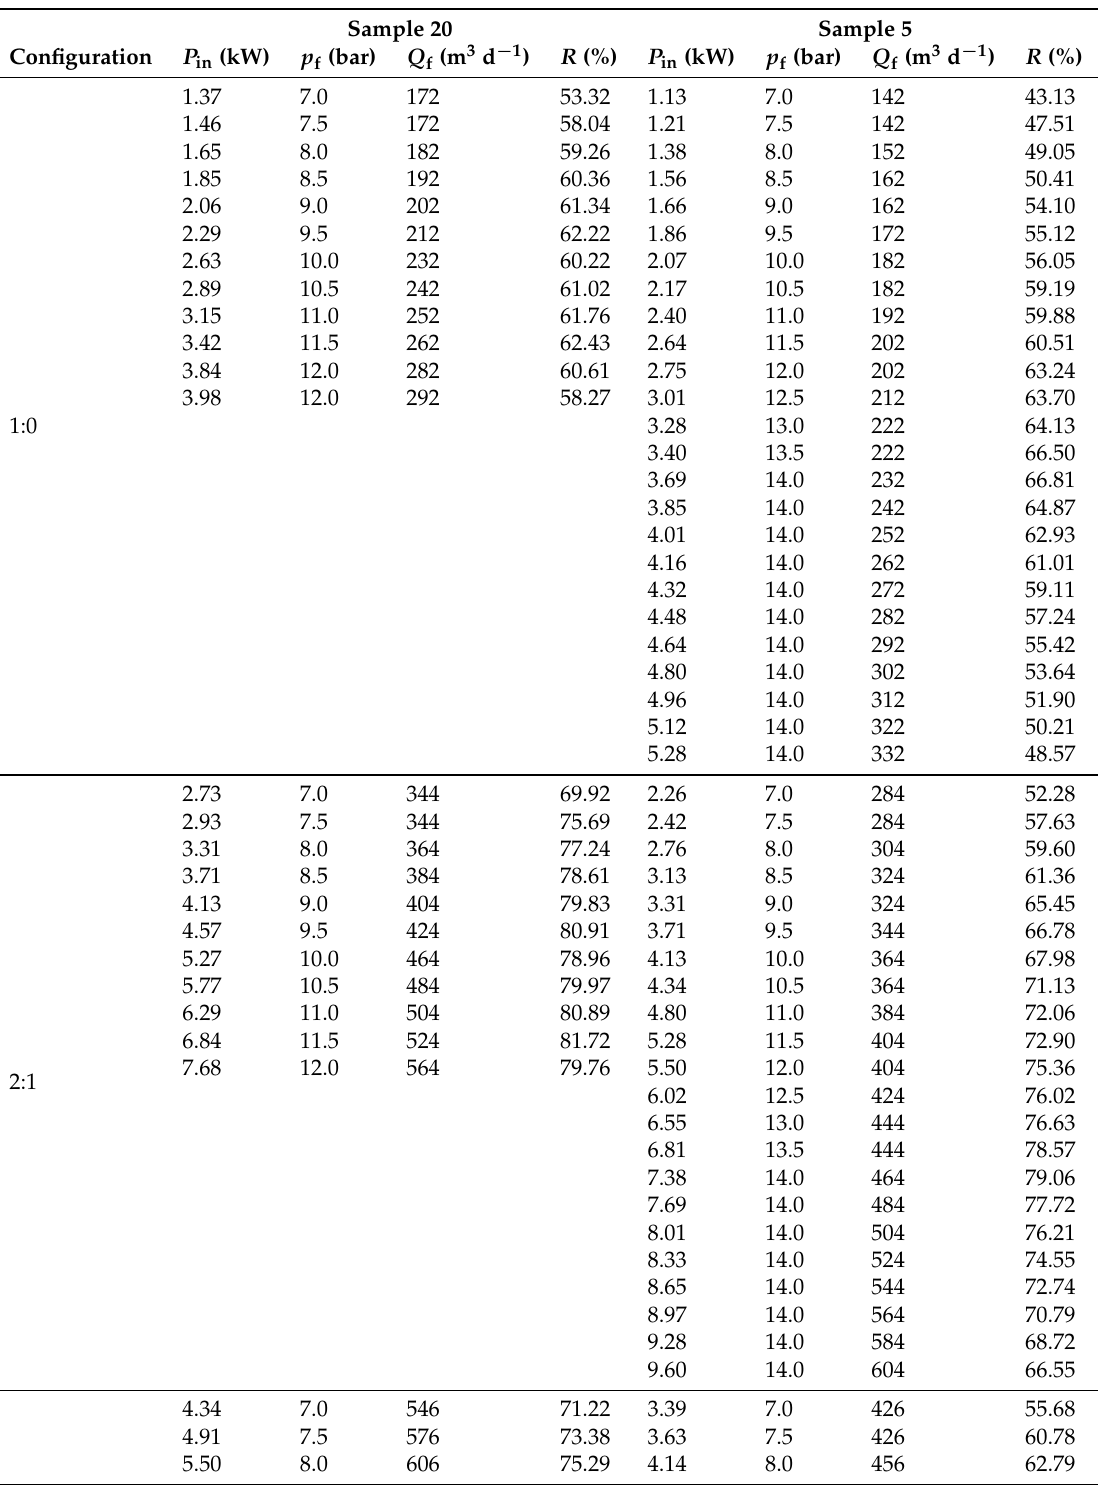
Table A1. P in , p f , Q f and R for maximizing Q p considering three different BWRO configurations and using samples 20 and 5 (Table 1) as